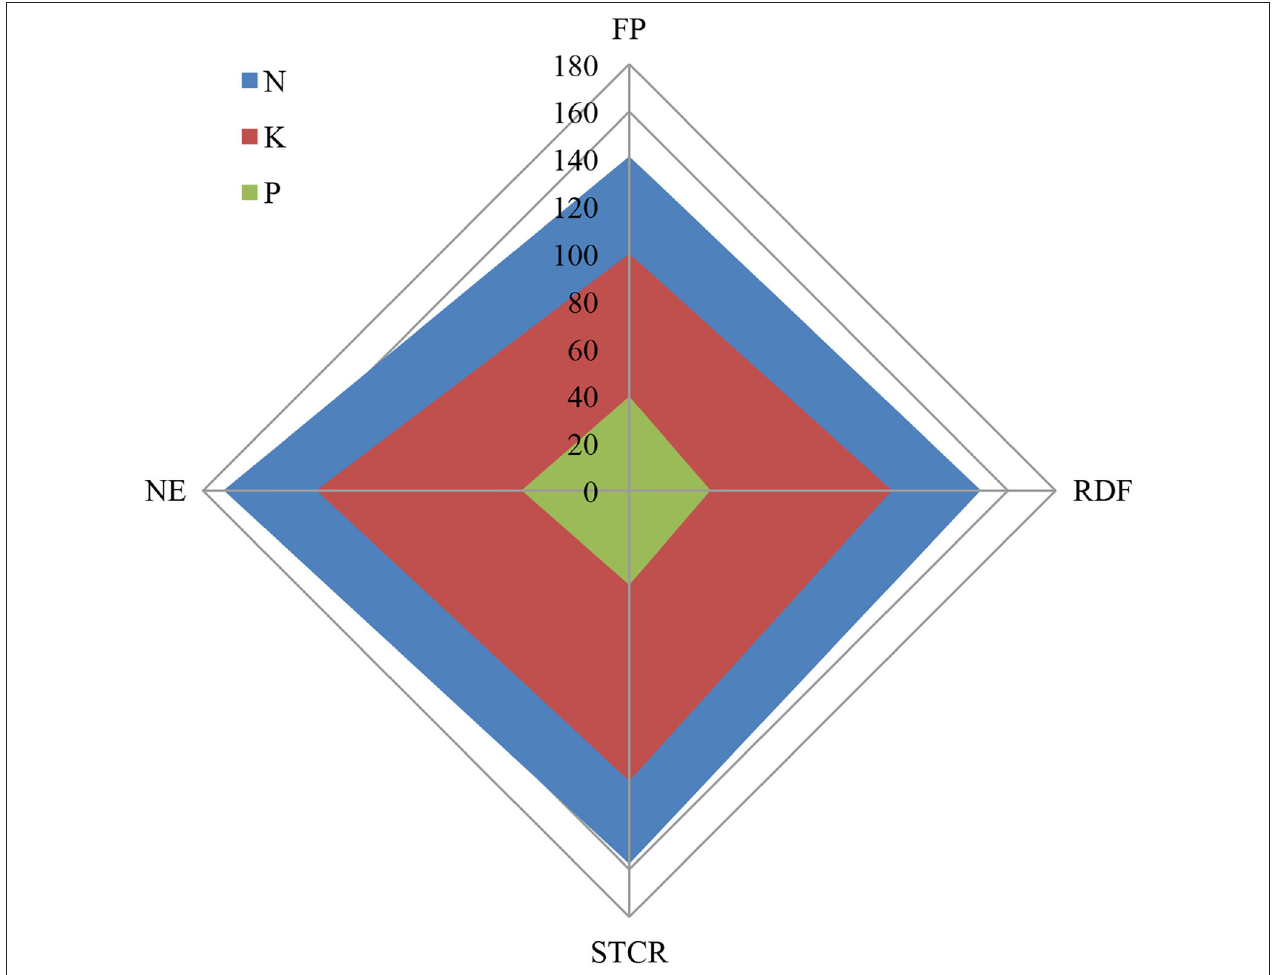
FIGURE 3 | Total nutrient uptake (kg ha − 1 ), at harvest, as affected by the nutrient management practices averaged over years and across locations.